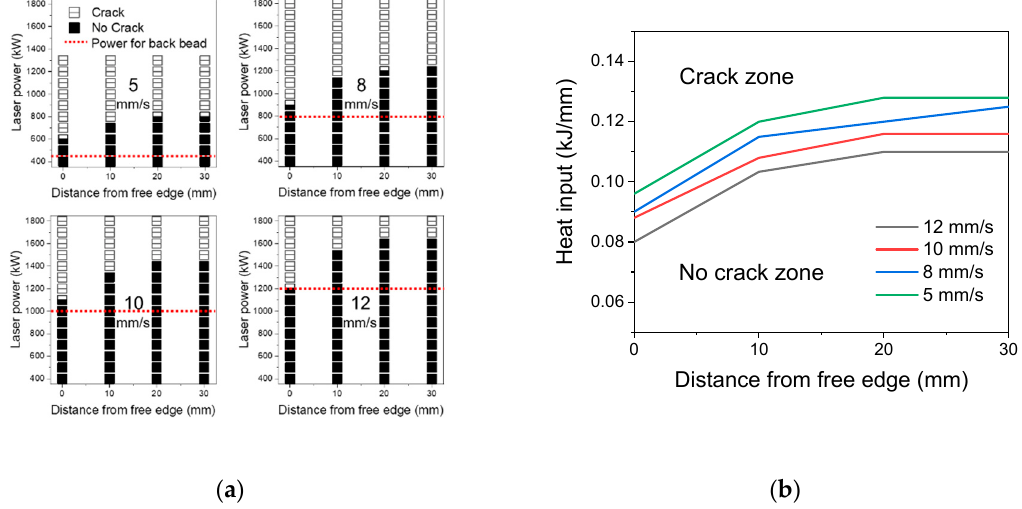
Figure 2. ( a ) Database of free edge test for base material (BM) under various welding conditions and ( b ) the graph showing relationship of heat input and welding speed on cracking susceptibility. As the laser welding speed increases, the laser power for occurring back beads (red dotted line) and cracks also increases. Since similar beads are formed under equal heat input per unit length, a high output is required to form back beads at the high speed. To compare the effect of scan speed as shown in Figure 2b, the boundary line where cracks occur is converted into heat input and marked.